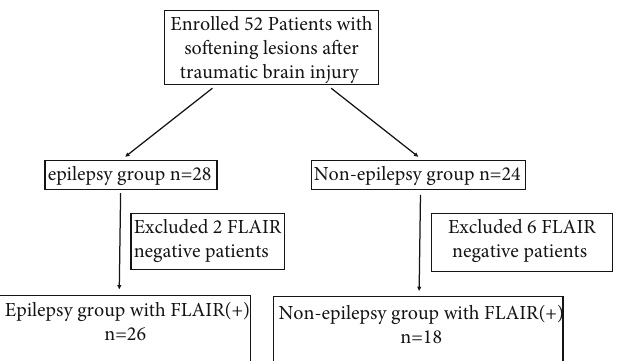
Figure 1: Flowchart. (1) Epilepsy group: after excluding two patients with FLAIR-based hypointensity, 26 patients with epilepsy with FLAIR hyperintensity were enrolled. (2) Nonepilepsy group: after excluding six patients with FLAIR-based hypointensity, we recruited 18 patients with no